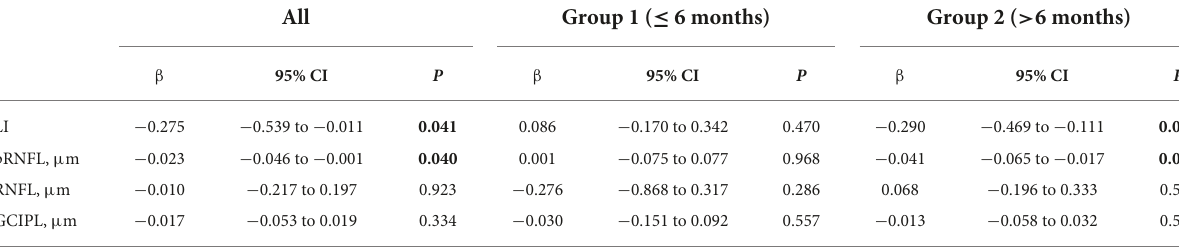
TABLE 3 Associations between LI and retina structural parameters with VA, LogMAR in patients with thalamic stroke, respectively. All Group 1 ( ≤ 6 months) Group 2 ( > 6 months)